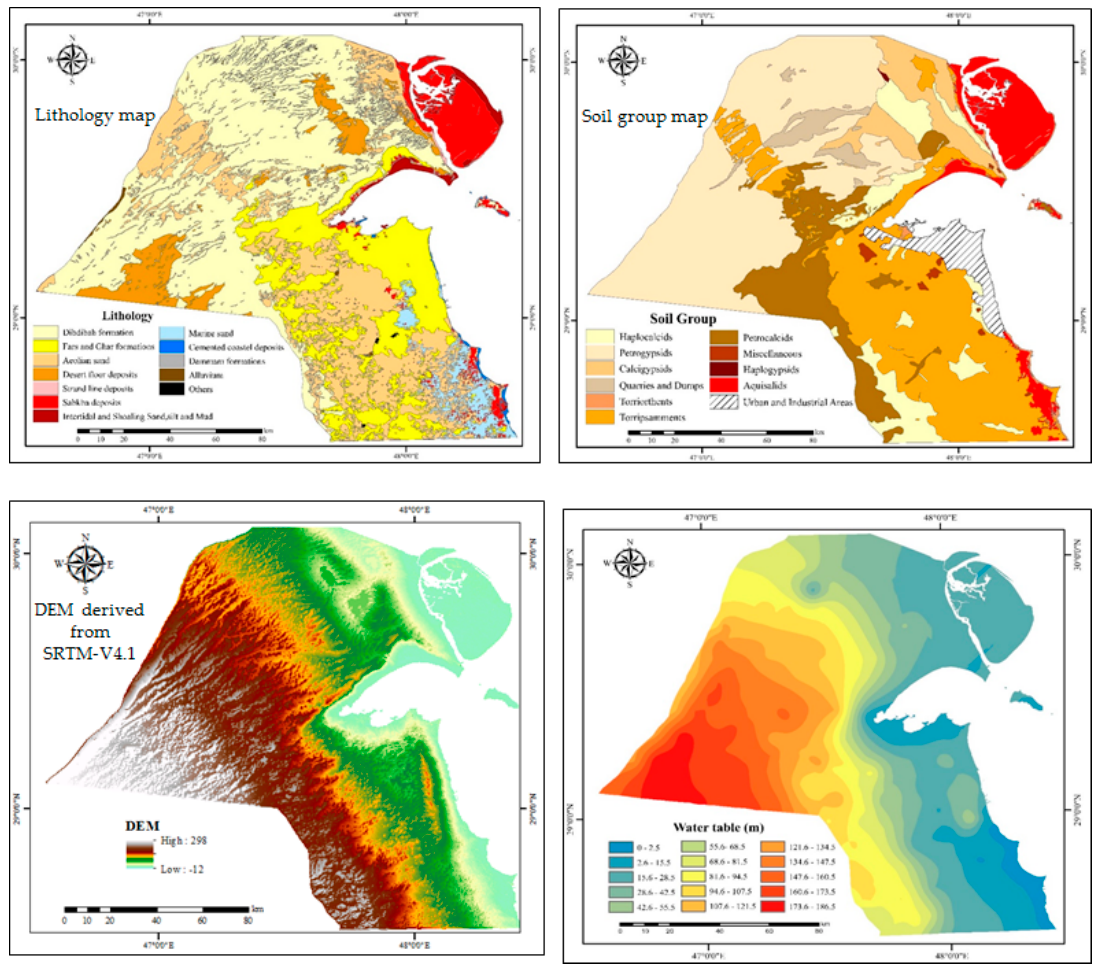
Figure 5. Ancillary data: soil, lithology, topography and water table maps.